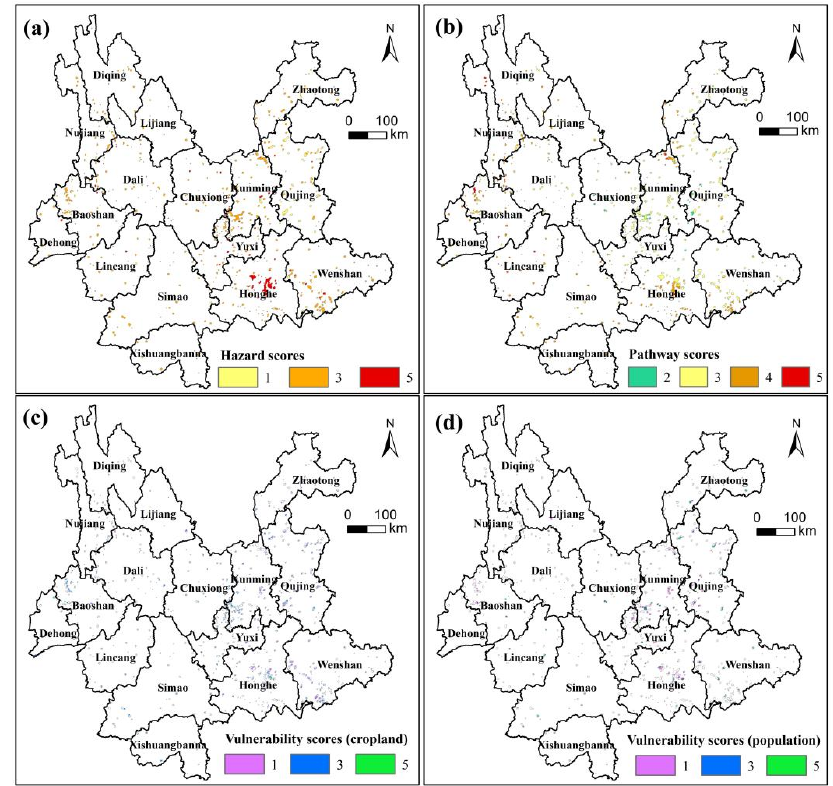
Figure 5. The 1 km scale risk assessment for ( a ) hazard scores, ( b ) pathway scores, and vulnerability of cropland ( c ), and population ( d ).